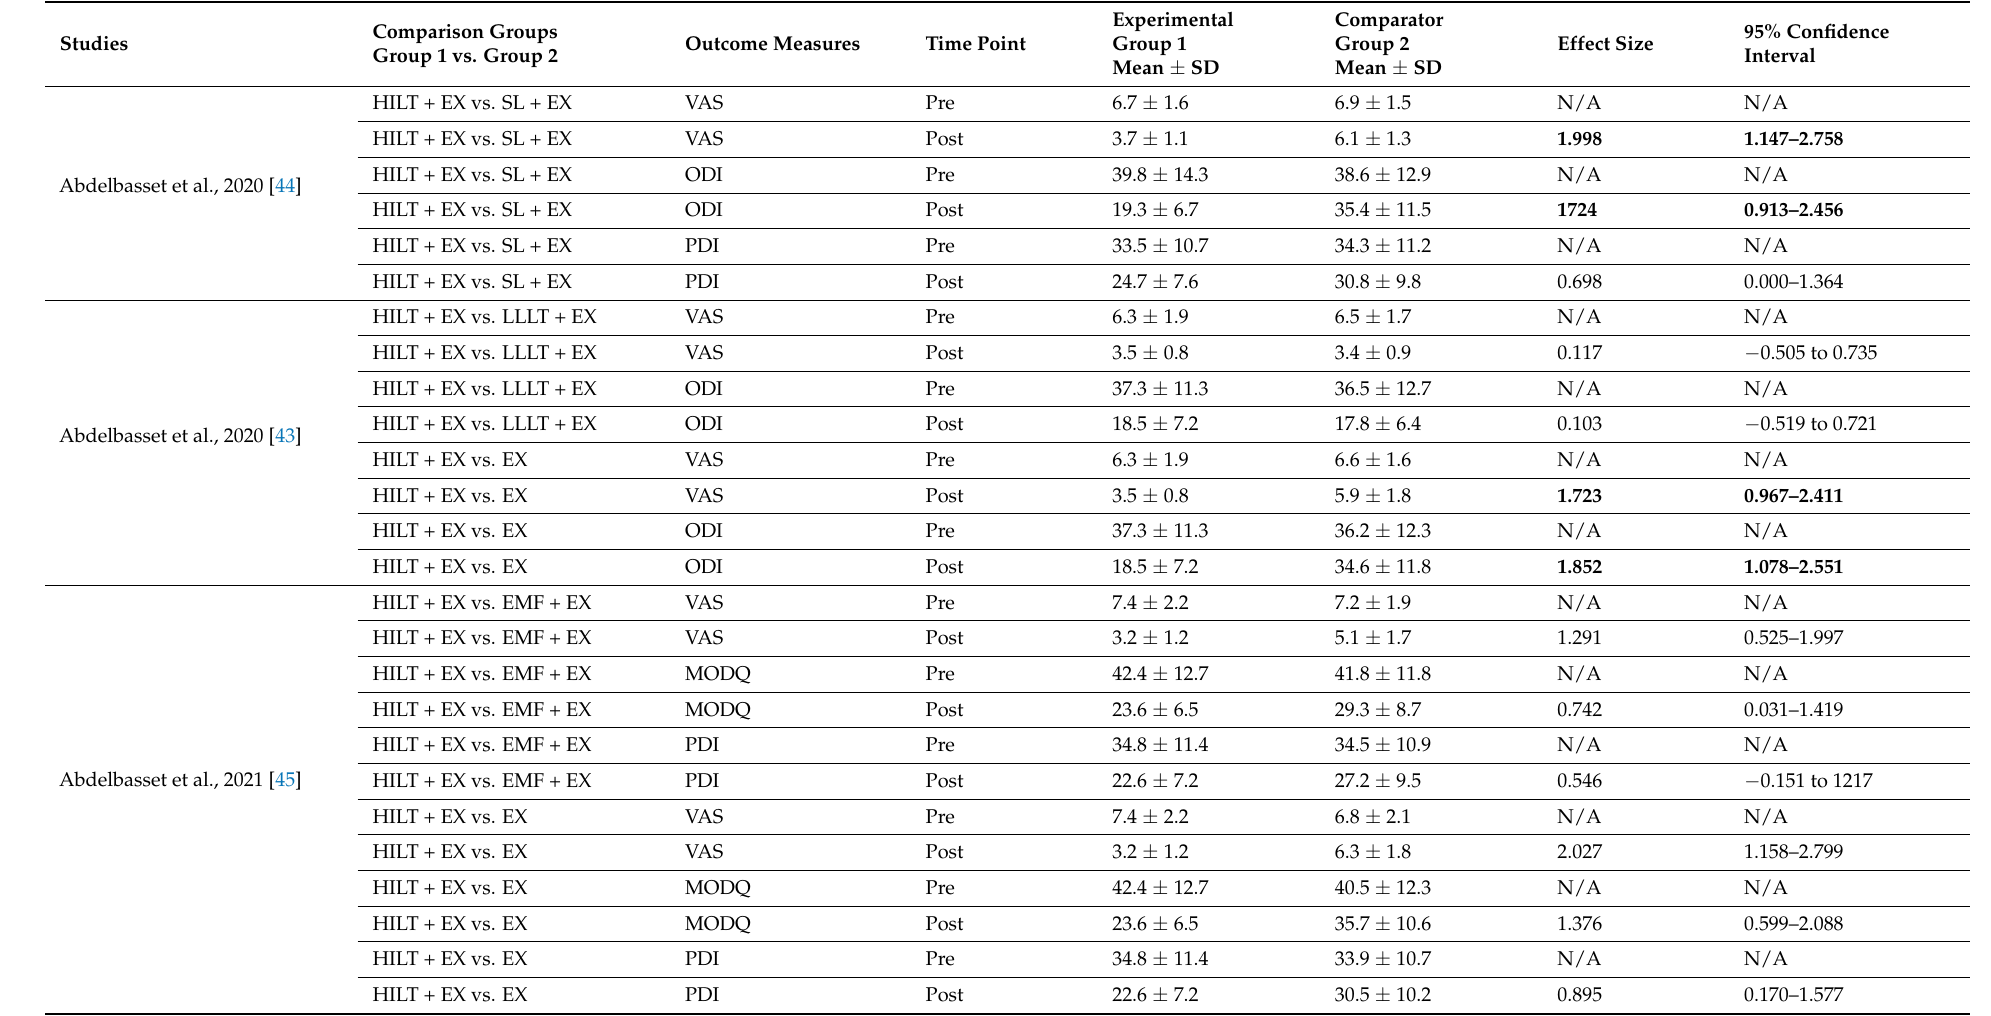
Table 4. Characteristics of the Cohen’s d effect sizes and 95% CIs for all time points for the included studies. Cohen’s d effect sizes were interpreted as weak if between 0.2 and 0.49, medium if between 0.5 and 0.79, large if between 0.8 and 1.19, very large if between 1.2 and 1.99, and huge if equal or higher than